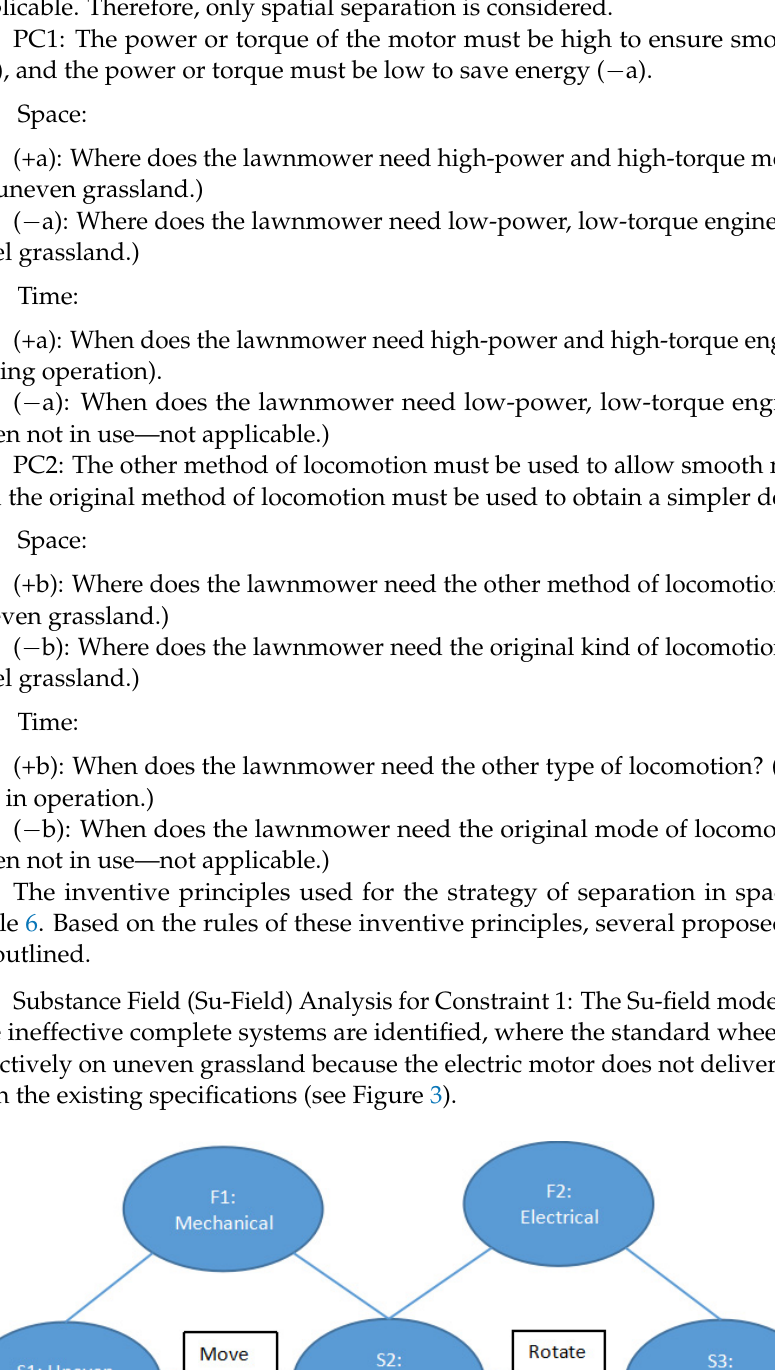
Figure 4. Improved Su-field model for constraint 1. Resolving Constraint 2: Figure 5 shows the CEC analysis for constraint 2. According to the CEC, the product needs to be recharged frequently because the battery runs out quickly due to its low capacity. For each stated cause, an obvious solution is proposed. A step-by-step application of the TRIZ analysis tools for the identified constraint follows: Constraint 2: Needs frequent recharging.